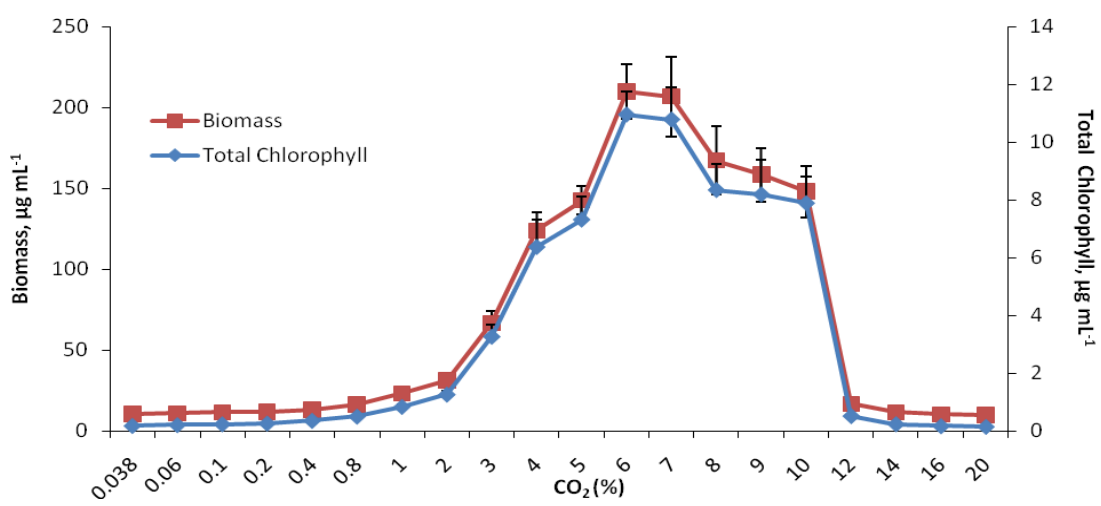
concentrations. 2